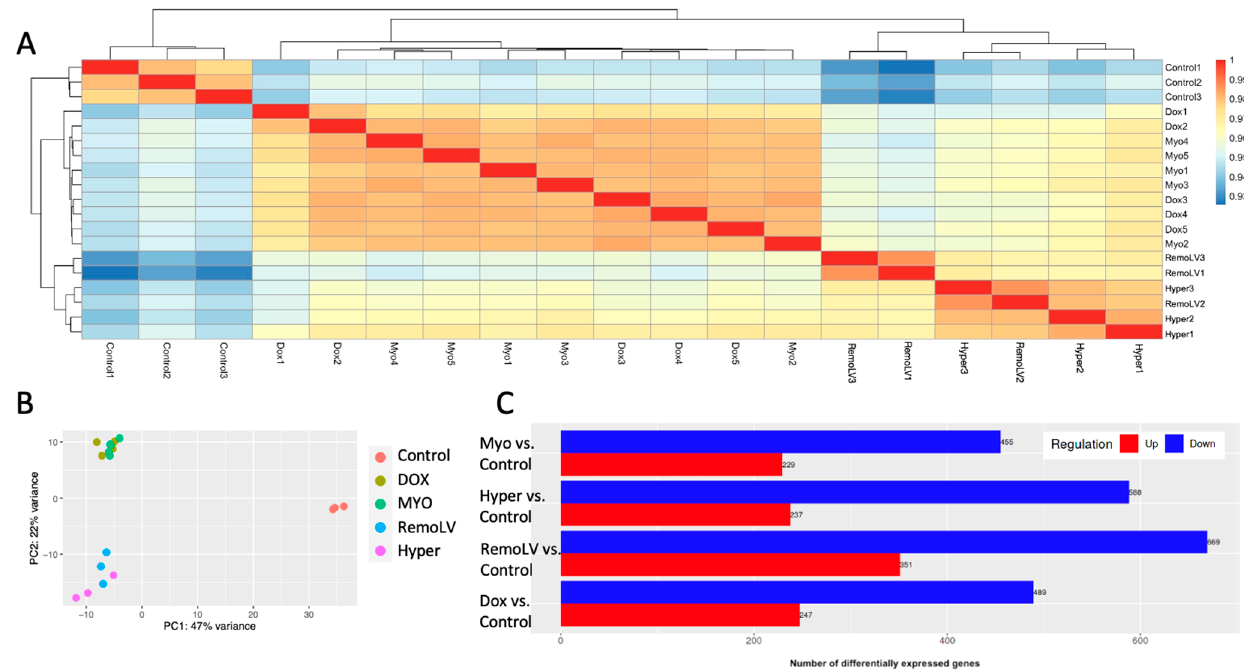
Figure 1. Global gene expression changes in MF models. Unsupervised two-dimensional hierarchical clustering of samples based on gene expression level ( A ). Different colors in principal component analysis indicate different treatment models ( B ). Bars representing the number of up- and down-regulated genes in all treatment groups compared to control with adjusted cut-offs: FDR = 0.05, LFC = ±2 ( C ).